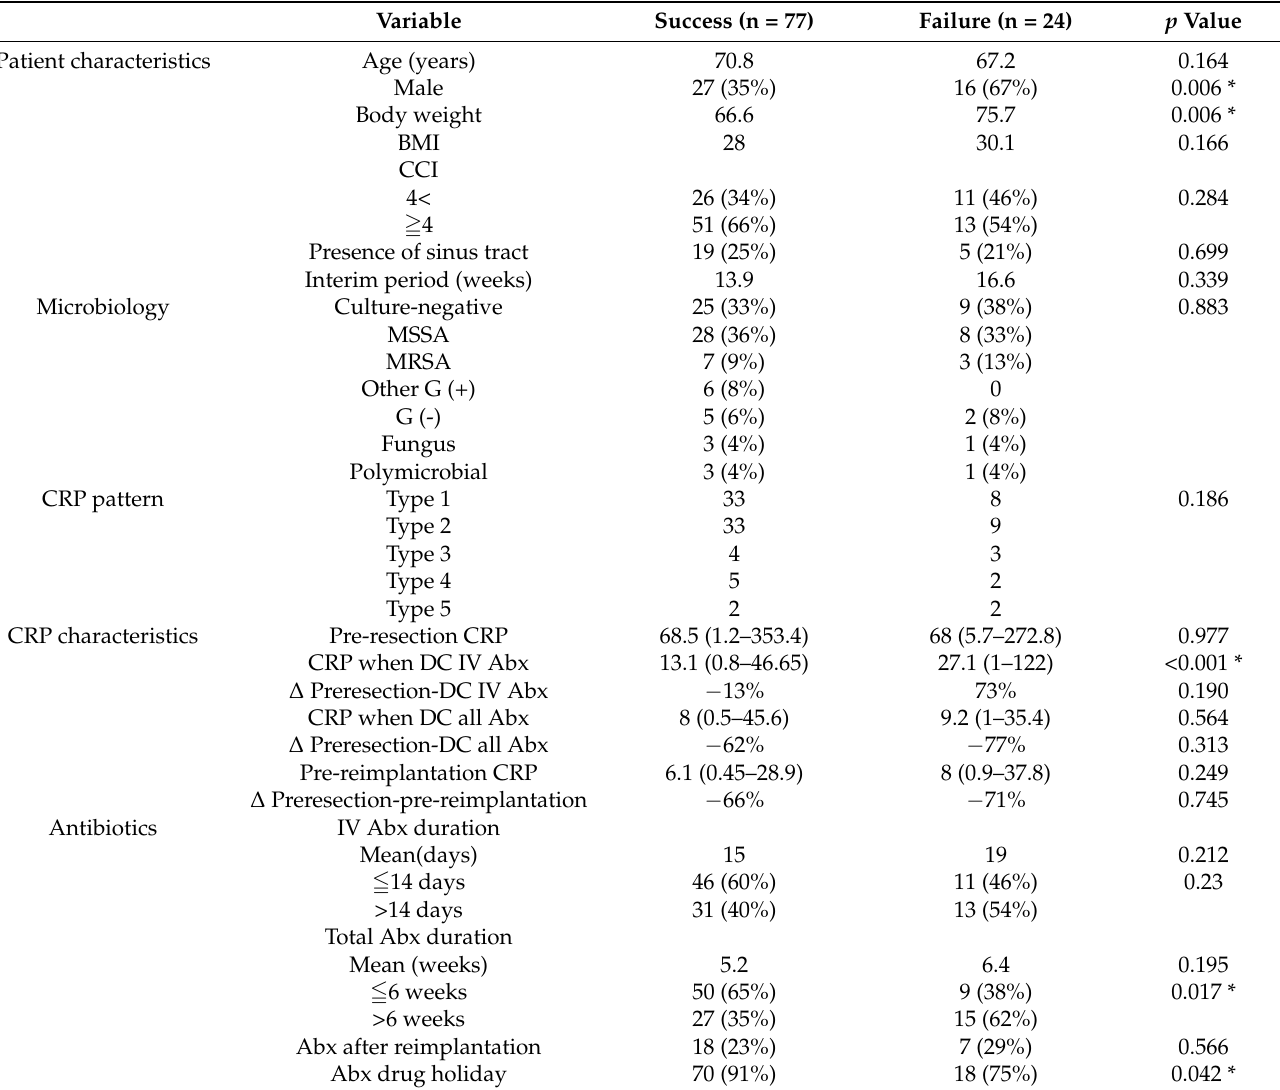
Table 2. Association of treatment outcome and variables. Treatment outcome was defined by modified Delphi criteria. Variable Success (n = 77) Failure (n = 24) p